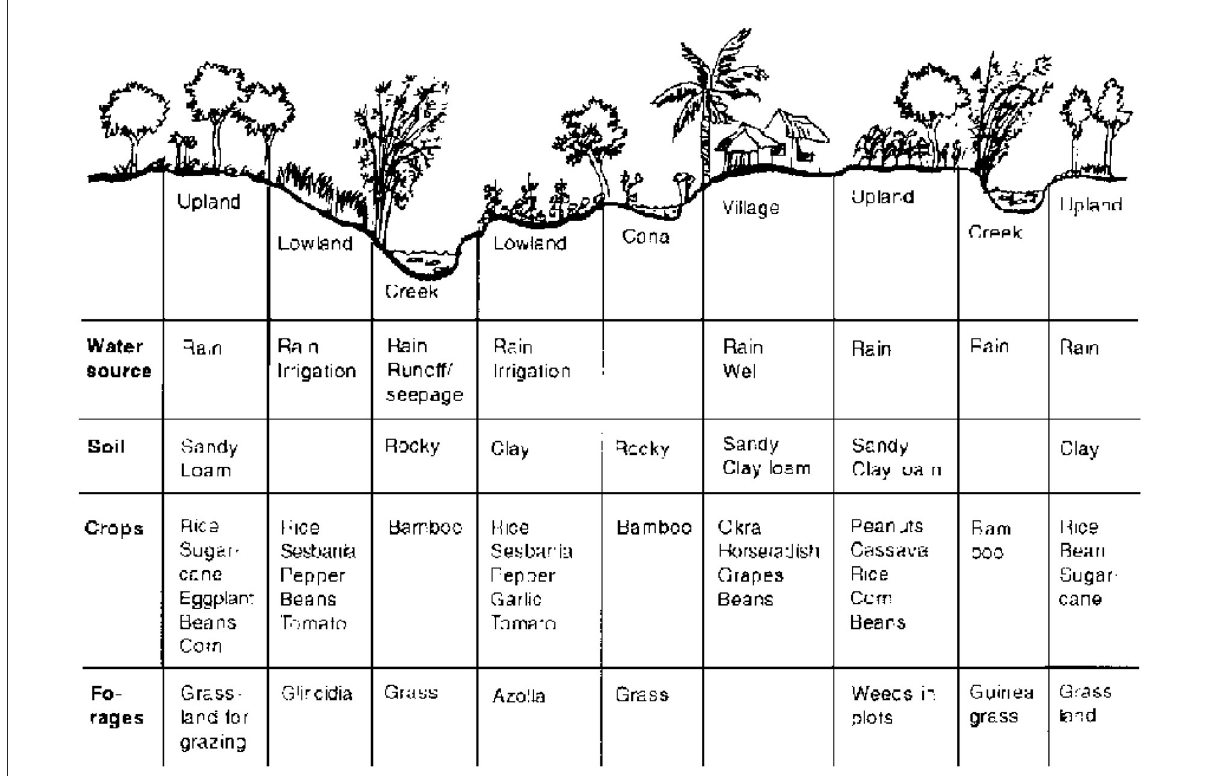
FIGURE5 Transect map (nzdl.org).